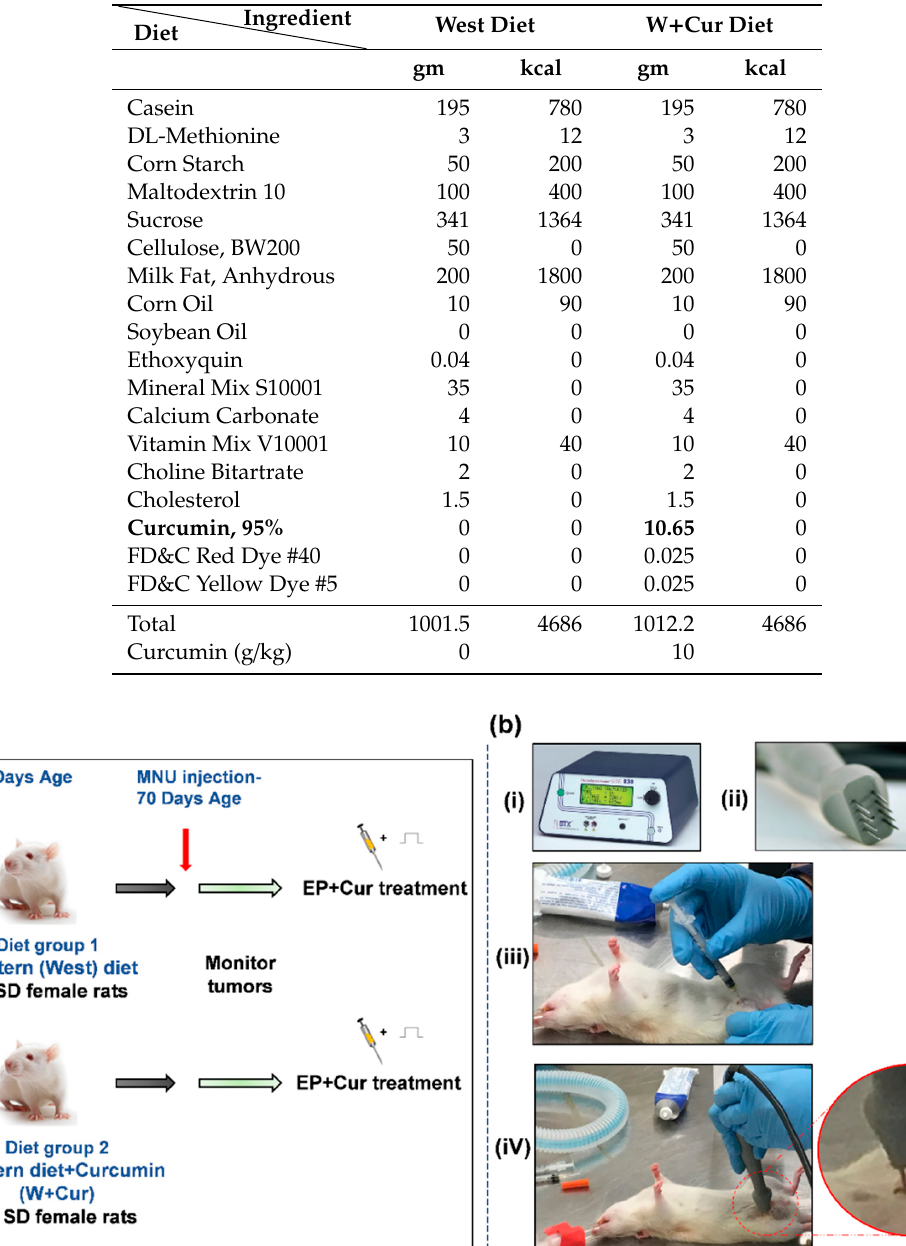
Table 1. The ingredients of western (West) diet and western diet supplemented with 1% w / w curcumin